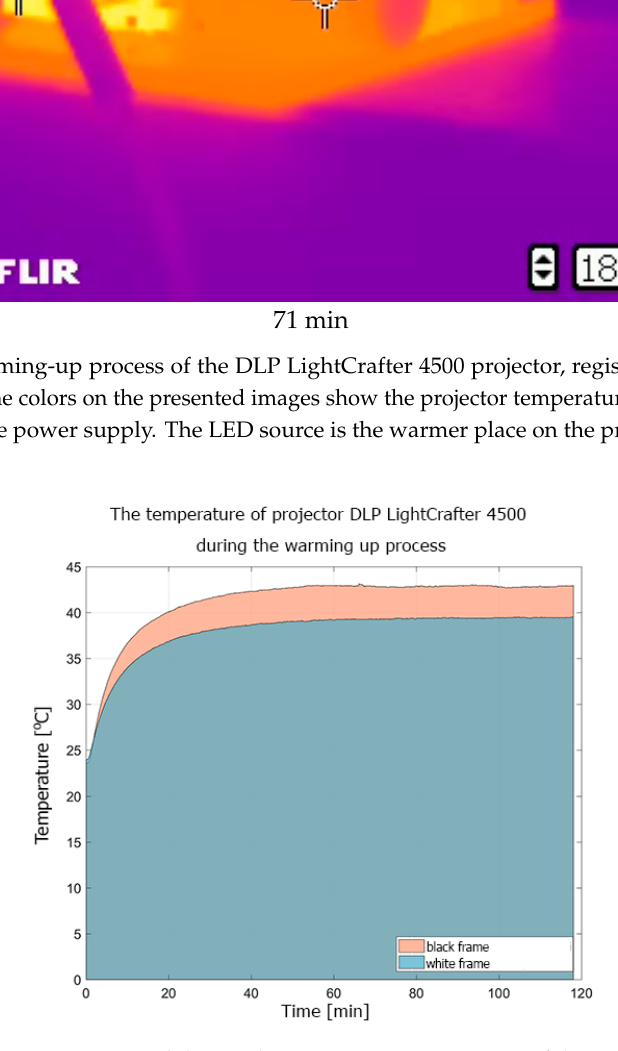
Figure 4. The temperature registered during the warming-up experiment of the DLP LightCrafter 4500 projector displaying white and black frames. The temperature was measured by the PT100 sensor attached to the LED light sources.